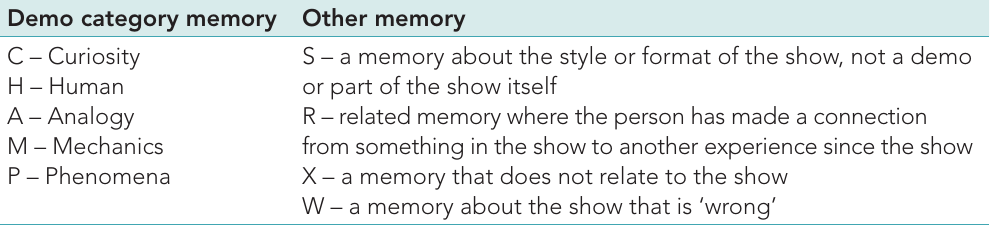
Table 3: explanations and abbreviations for focus group